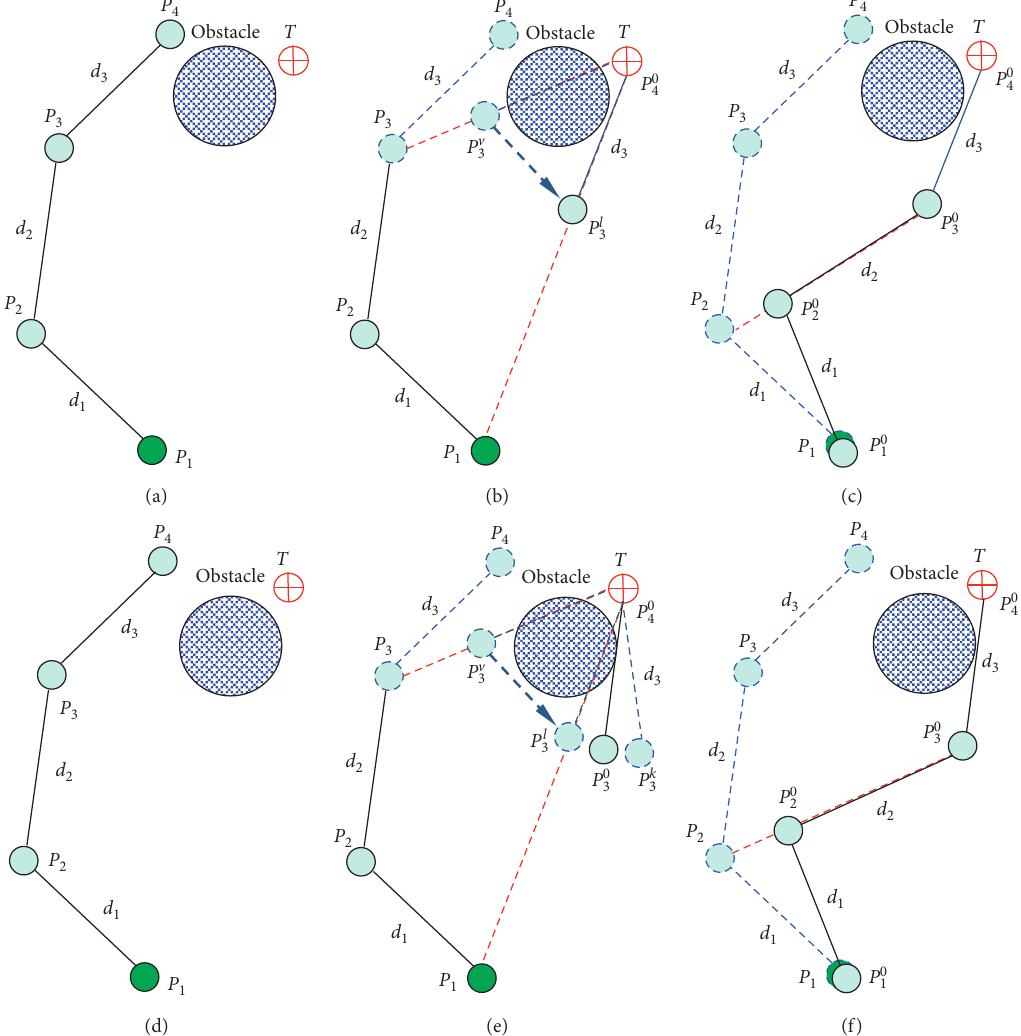
Figure 2: Extending FABRIK with obstacle avoidance. (a), (d) The initial state of the manipulator, the target position, and the obstacle. (b), (e) P 4 moved to the target position ( T ) and the optimization P 0 and P 0 1